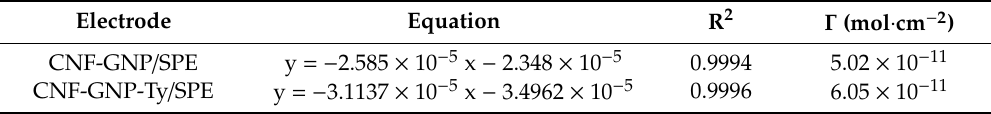
Table 5. The linear fitting equations (i c vs. v), R 2 and Γ .